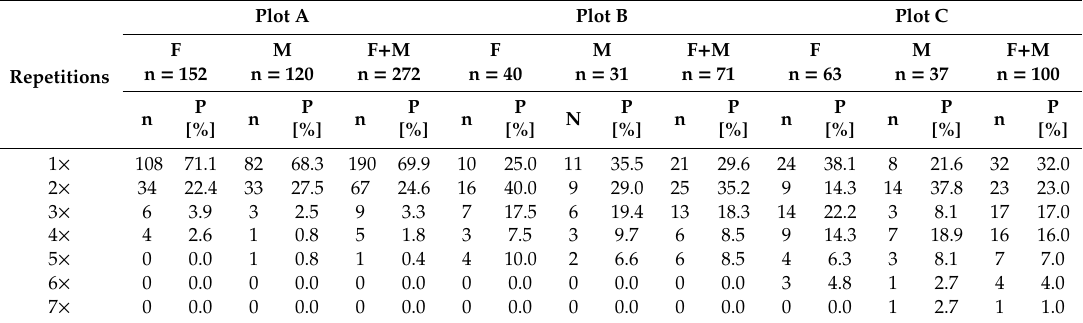
Table 2. Repetitive activity of Dermacentor reticulatus adults in the examined plots in eastern Poland